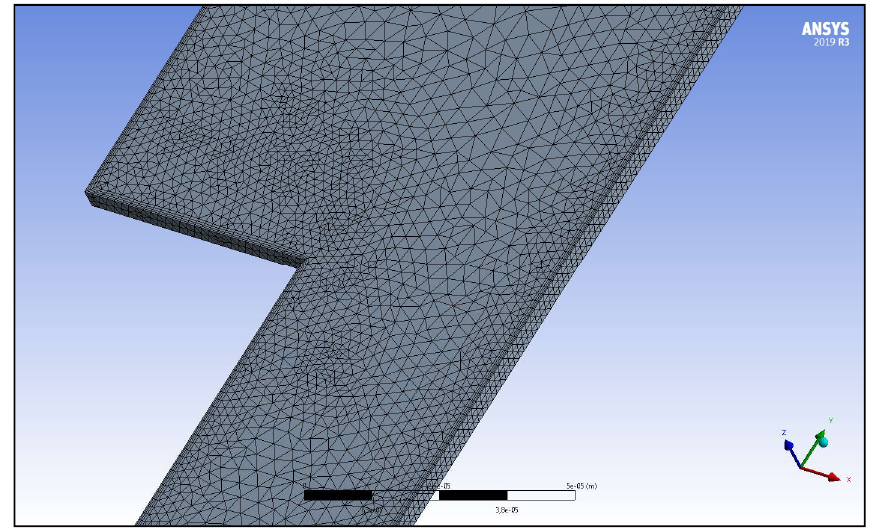
Figure 5. Simplified slot channel geometry with step-type sector-wide clearance variation.